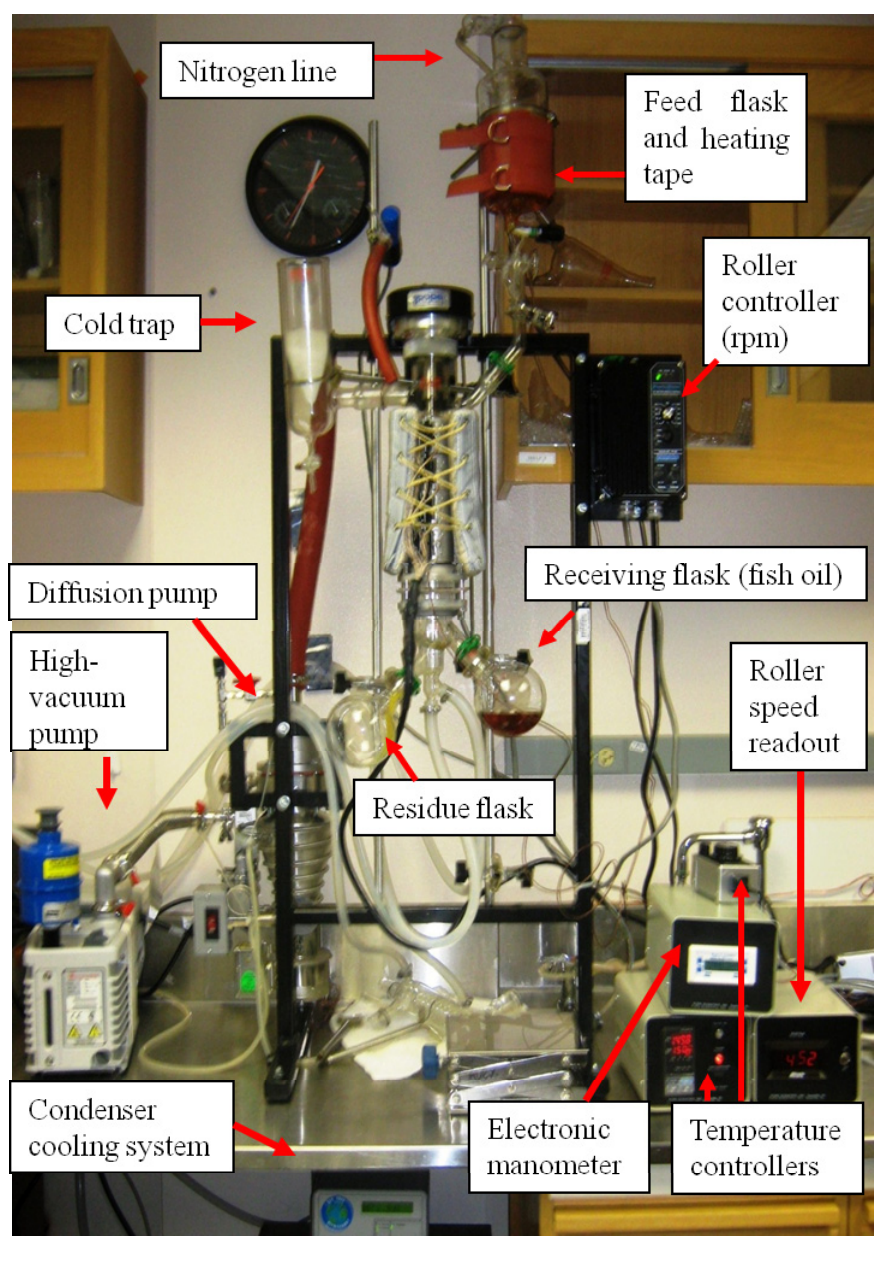
Figure 1. Short-path distillation (SPD)